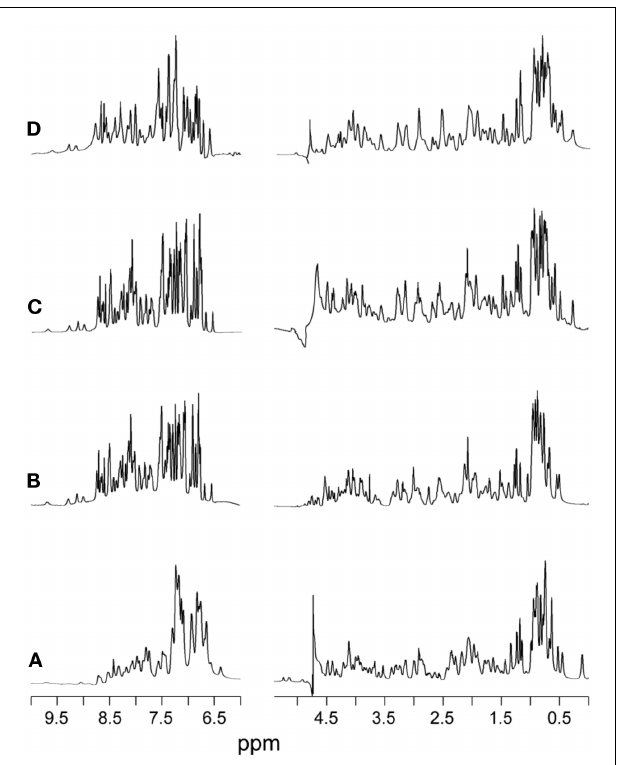
FIGURE 3 | 1 H-NMR spectra of KP-insulin at 700MHz. Spectra were obtained under a variety of solution conditions: (A) aqueous solution at pH 7.4 and 32˚C, (B) 20% (v/v) deuterioacetic acid (pH 2.0) at 32˚C, (C) 10mM deuterioacetic acid (pH 3.0) at 32˚C, and (D) 10mM deuterioacetic acid (pH 3.0) at 25˚C. In each panel the amide-aromatic spectrum in H 2 O is shown at left, and the aliphatic spectrum in D 2 O is shown at right.